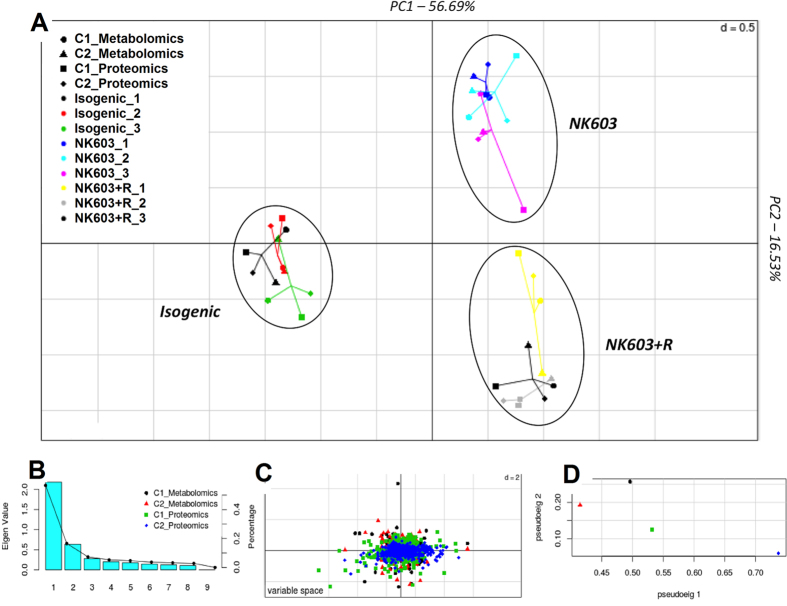
Integration of metabolome and proteome profiles of the NK603 maize and its near-isogenic counterpart into a multiple co-inertia analysis projection plot.(A) The first two axes of MCIA represent metabolome and proteomic datasets. Different shapes represent the different variables which are connected by lines, the length of these lines is proportional to the divergence between the data. Lines for each sample are joined at a common point at which the covariance derived from the MCIA analysis is maximal. (B) Pseudo-eigenvalue space showing the percentage of variance explained by each of the MCIA component. Each barplot represents the absolute eigenvalues. (C) Protein or metabolites (colored dots) are projected on a 2-dimensional space. In this panel, a protein or a metabolite that is particularly highly expressed in a maize variety will be located on the direction of this variety. (D) Pseudo-eigenvalues space of all datasets, indicating how much variance of an eigenvalue is contributed by the proteome or the metabolome for cultivations 1 and 2.